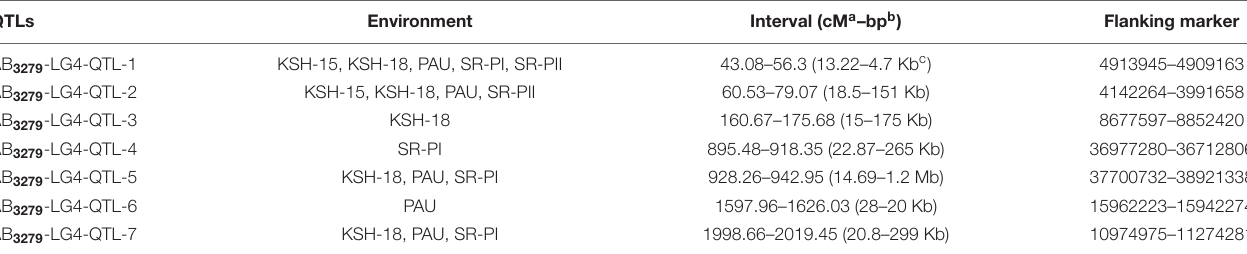
TABLE 5 | Quantitative trait loci associated with AB resistance identified in ILC3279 × ILC1929 population on chromosome